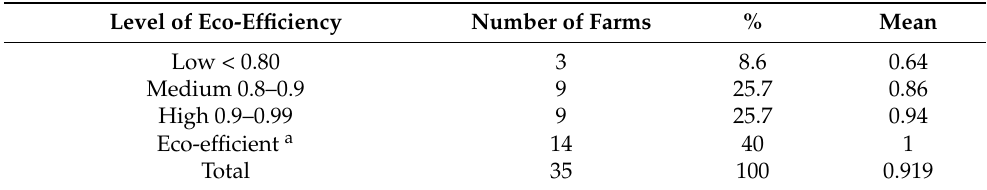
Table 4. Frequency distribution of farms, by eco-efficiency estimates from the data envelopment analysis (DEA) model ( n =